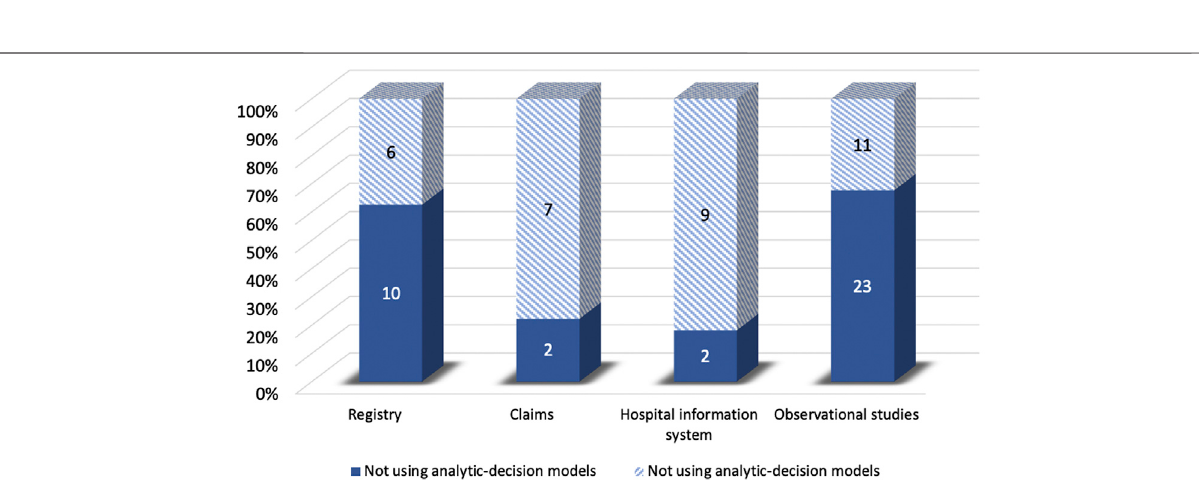
Frontiers in Pharmacology |